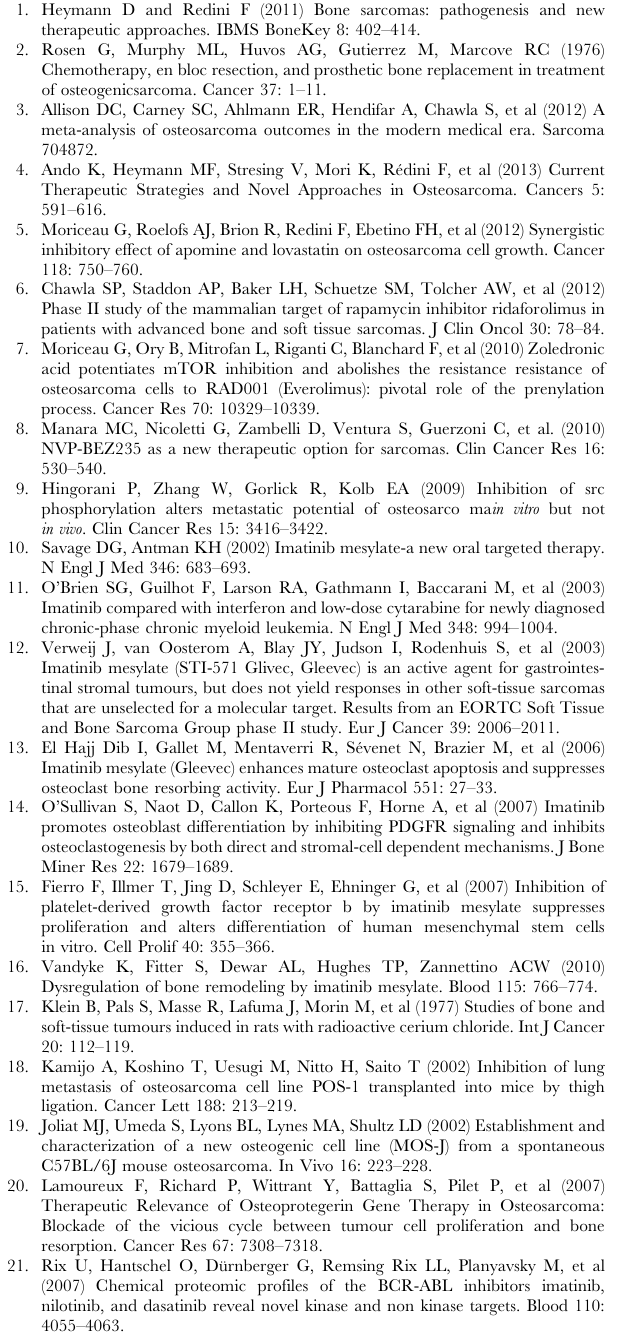
Figure S4 Imatinib mesylate exhibits a dual effect on osteoblast differentiation. Human mesenchymal stem cells (hMSC) were isolated, cultured, differentiated in osteoblasts and [45]. hMSC were cultured in the presence or absence of increasing form mineralized matrix in vitro was revealed by alizarin red Bone Sialo Protein (D)] were followed by quantitative